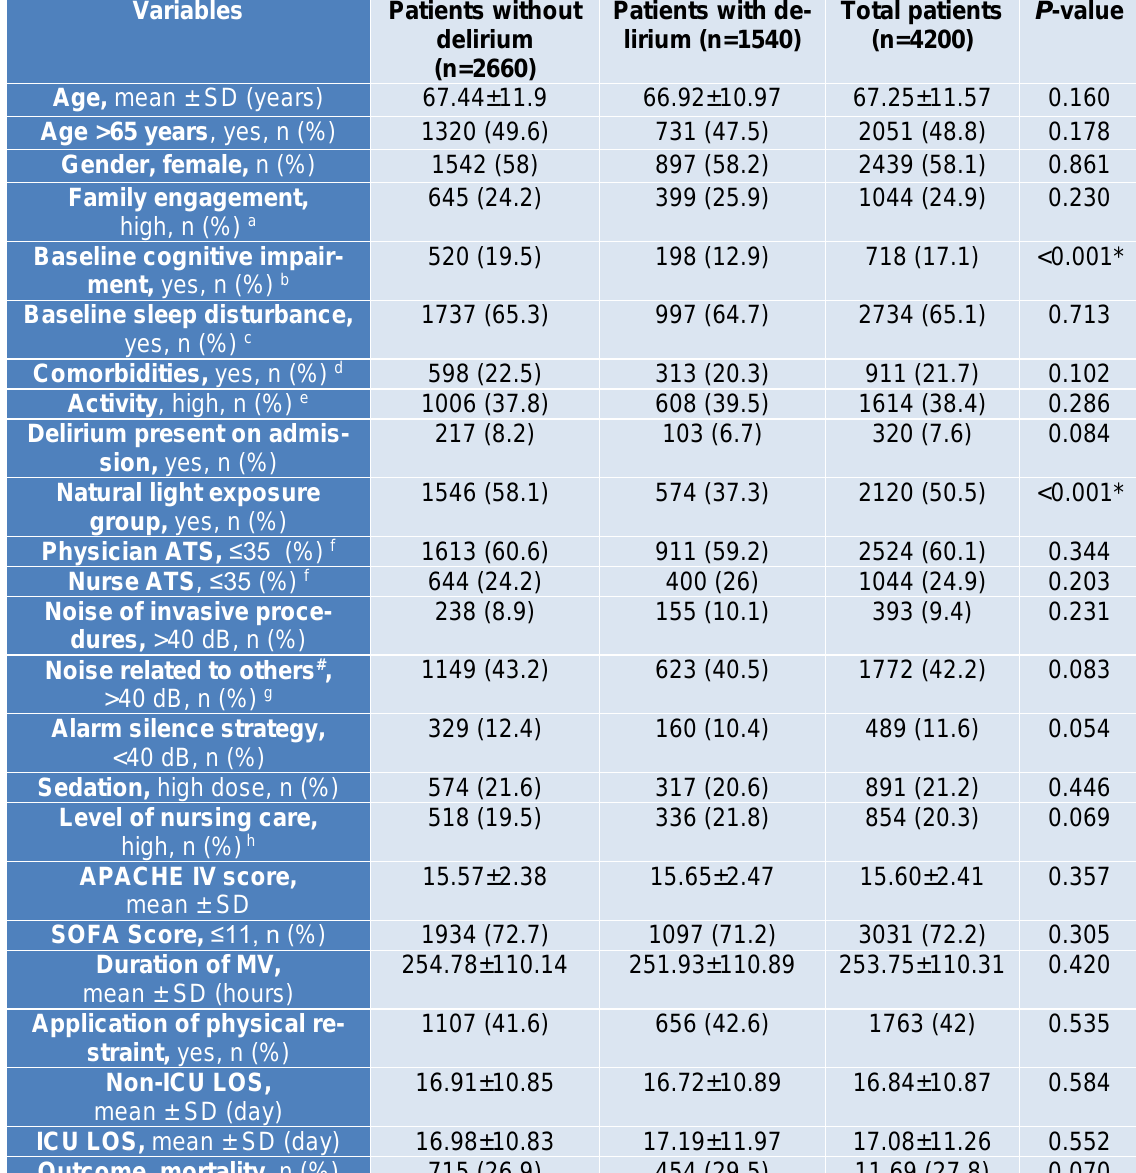
Table 1: Demographic and clinical characteristics of the participants according to with and without de- lirium Variables Patients